Question: State the chart type depicted above.
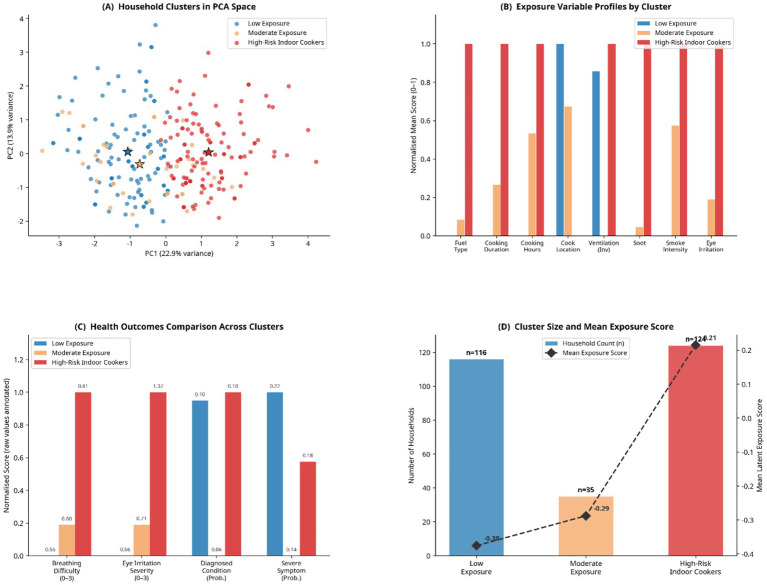
Answer: scatter